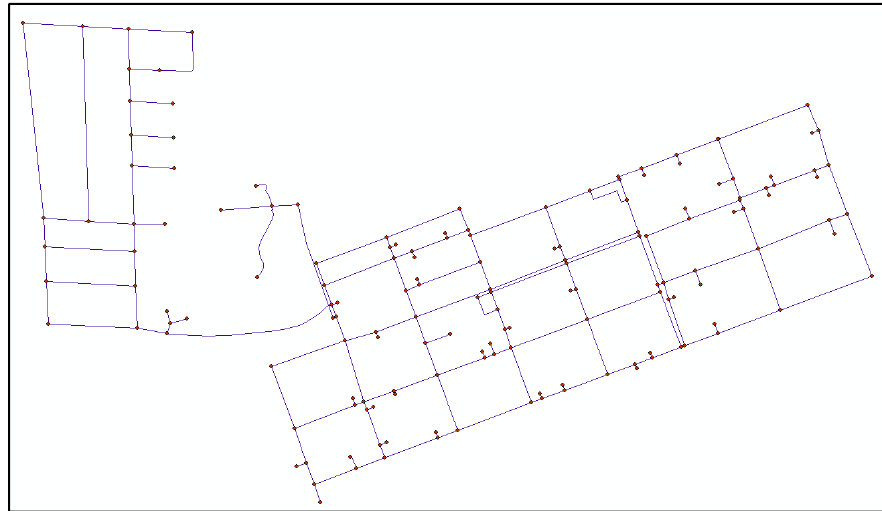
Figure 7. A layout of London Water Distribution Network, LWDN.